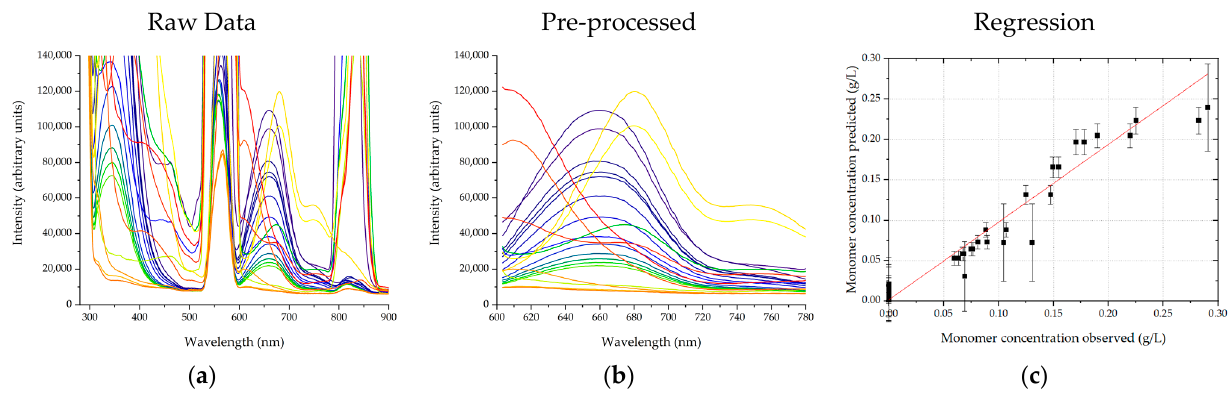
Figure 10. Data of fluorescence spectra ( a ), shortened spectra ( b ) and PLS results ( c ). Spectra are color ‐ coded from high concentration (blue) to low concentration (red).